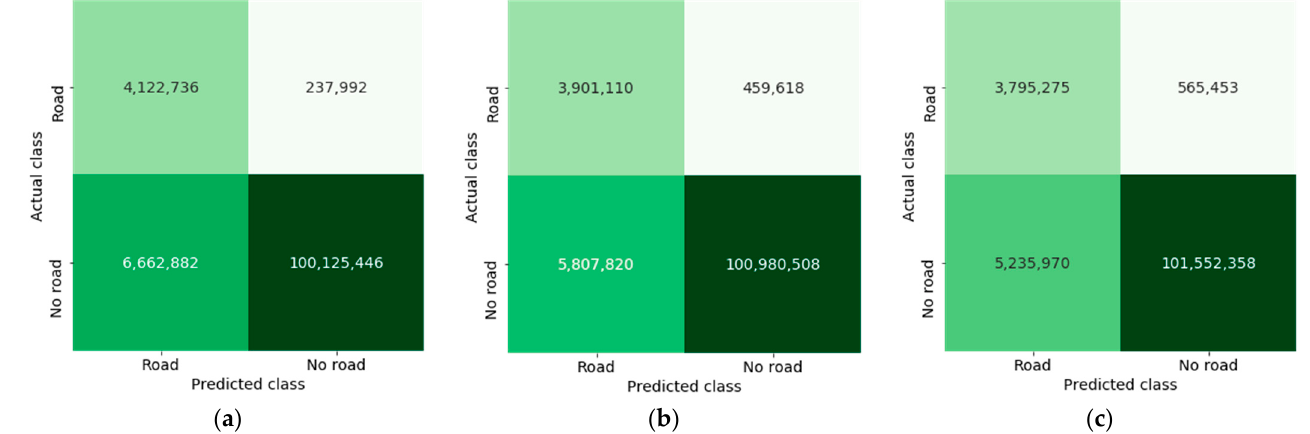
Figure 6. The confusion matrices obtained by ( a ) the semantic segmentation model U-Net [13]— SEResNeXt50 [16], and ( b ) Thin-structure-inpainting [15], together with ( c ) our implementation proposed in Section 5 (trained for deep inpainting operations) on the test set ( 𝑛 = 1696 tiles).